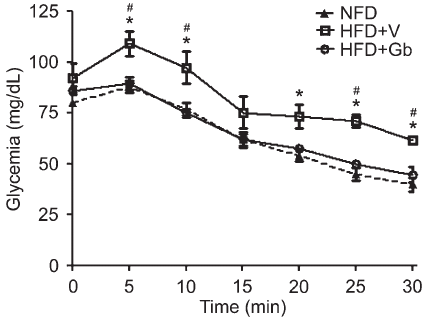
Figure 5. Insulin tolerance test (ITT) of normal fat diet (NFD; n=11), high-fat diet plus vehicle (HFD++V; n=6), and high-fat diet plus Ginkgo biloba (HFD++Gb; n=6) groups after phytother- apy treatment. *P , 0.05 vs NFD; # P , 0.05 vs HFD++Gb